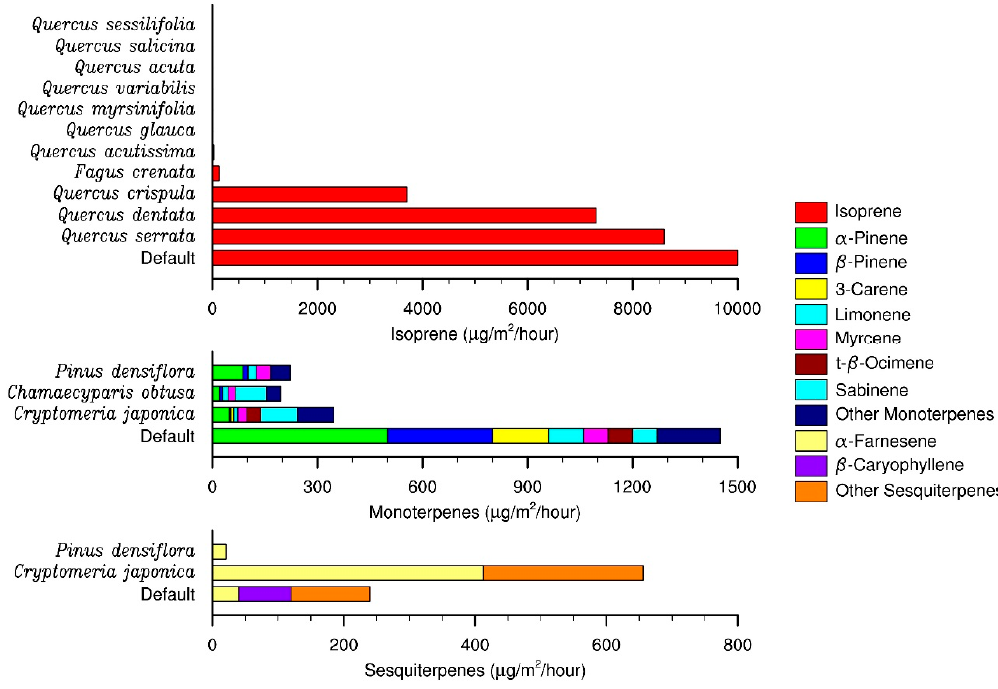
Figure 2. Default and newly developed EFs of isoprene, monoterpenes, and sesquiterpenes for major vegetation types.